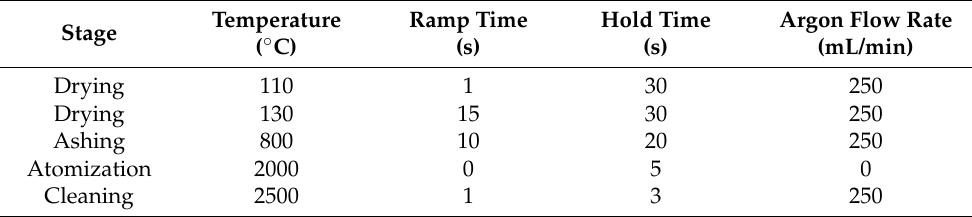
Table 1. Temperature program of graphite furnace for Cu